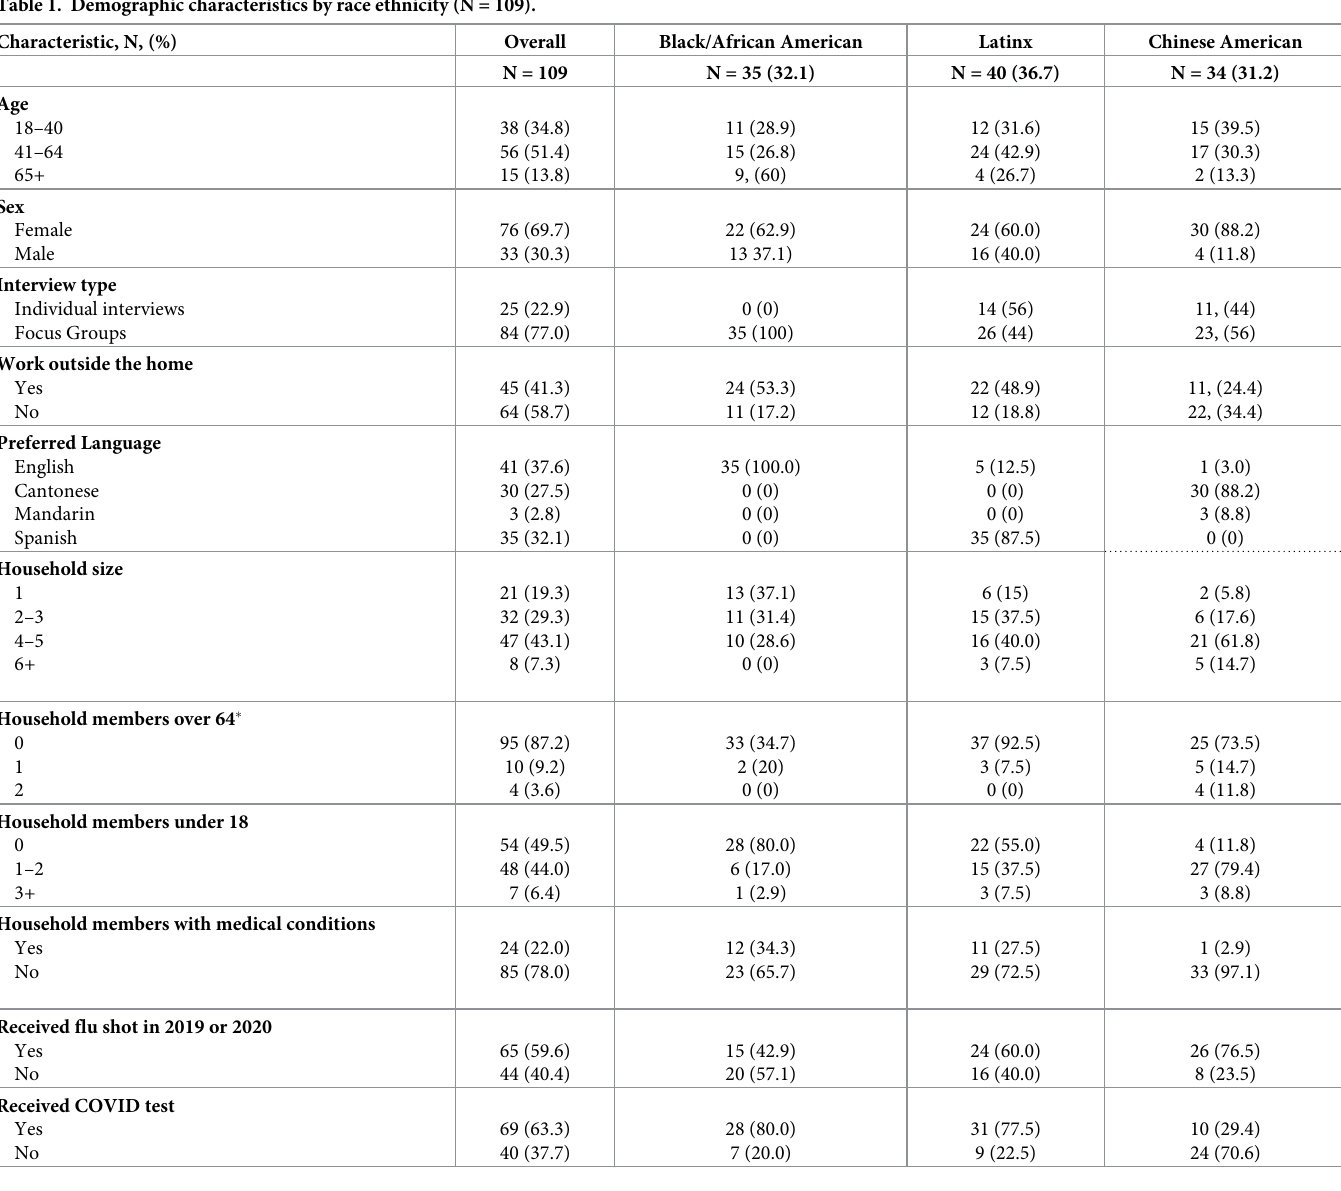
Table 1. Demographic characteristics by race ethnicity (N =